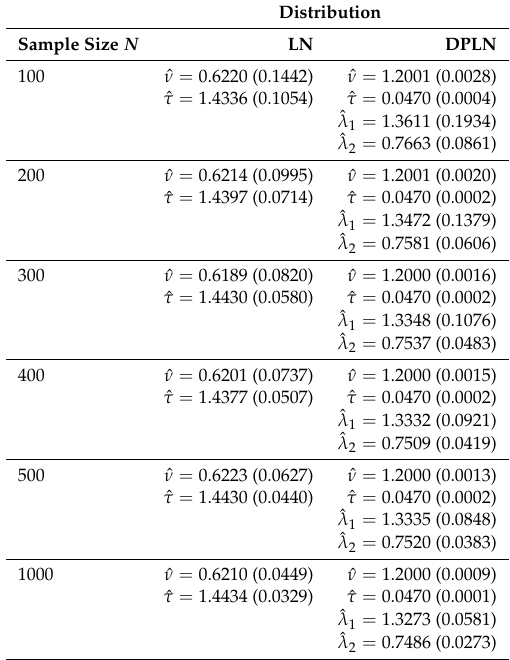
Table 5. Results of the simulation experiment involving 1000 simulations of data sets of size N , with standard errors shown in